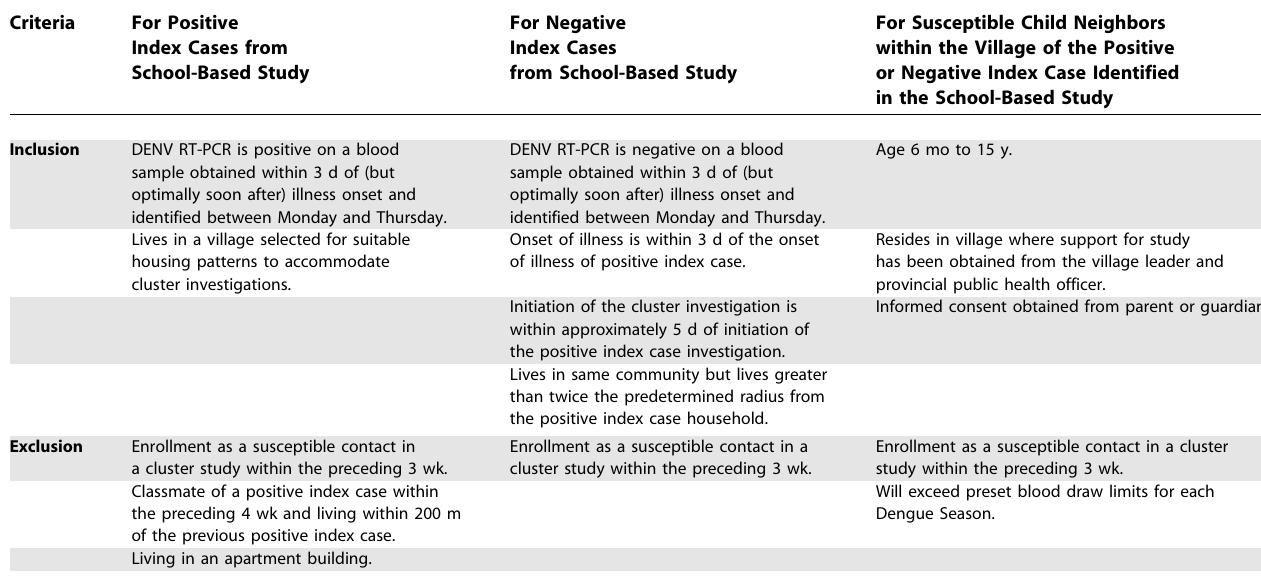
Table 1. Eligibility Criteria for Enrollment in Cluster